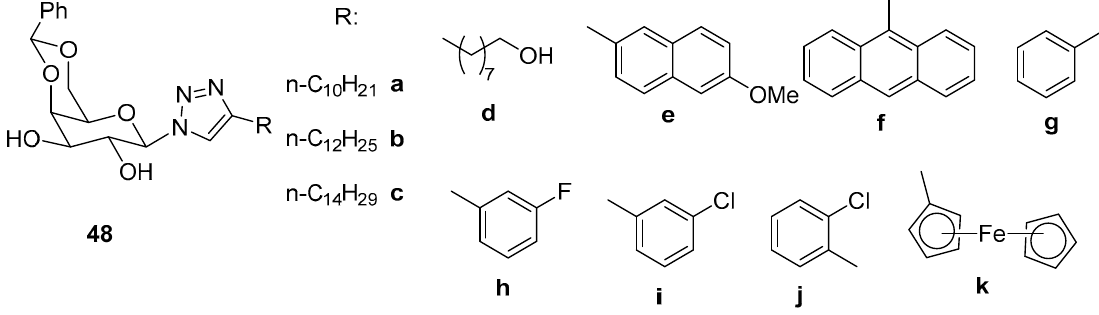
Figure 33. Structures of 4,6-O-benzylidene–galactopyranoside gelators [80].